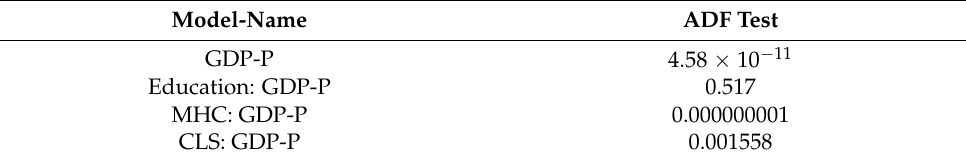
Table 12. The test results of cointegration between positive emotions and each